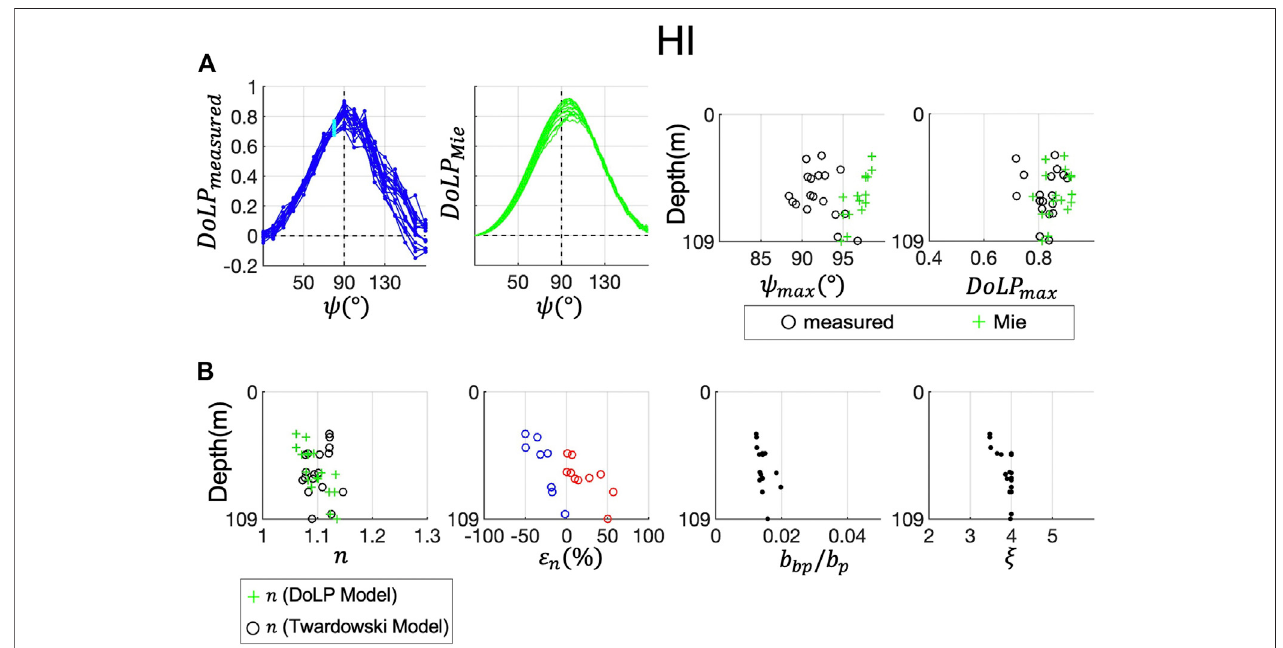
FIGURE 10 | Refractive index retrieval at fi eld site HI (Hawaii). Same as Figure 9 .